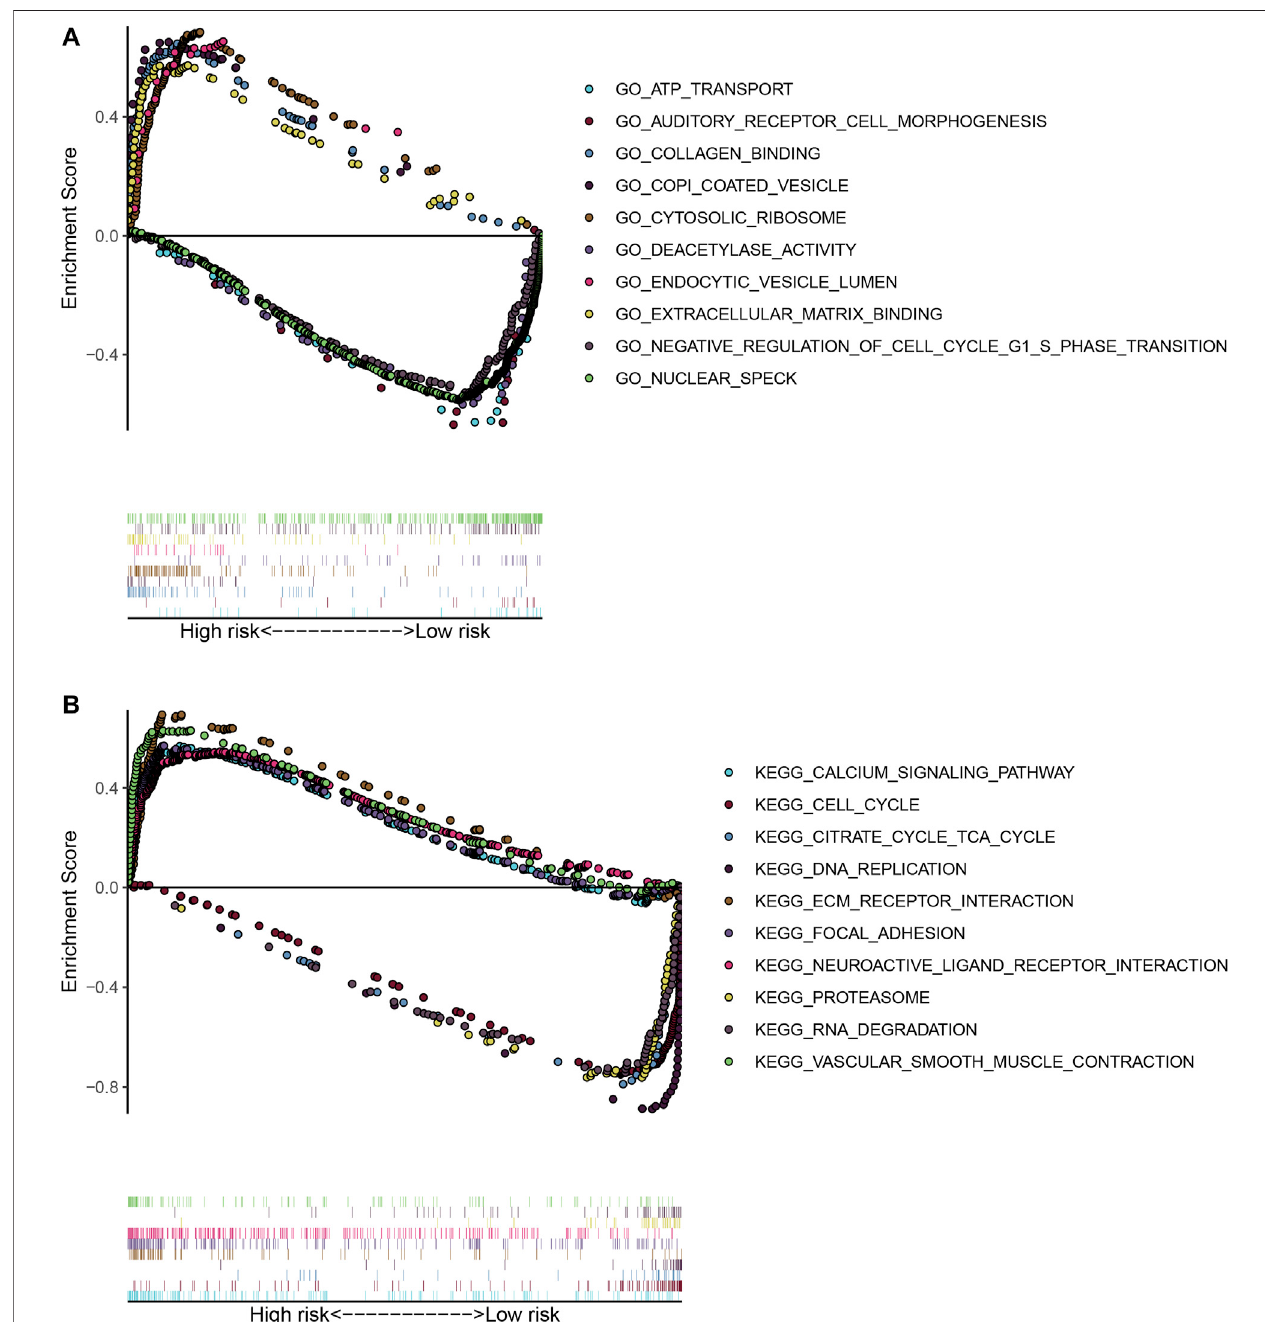
FIGURE5| GSEAontheTCGAcohorttoexploremechanismsunderlyingthe8-GILncSig. (A) GSEAGOidenti fi eshigh-andlow-riskrelatedsignalingpathwaysin HCC. (B) GSEA KEGG identi fi es high- and low-risk related signaling pathways in HCC.